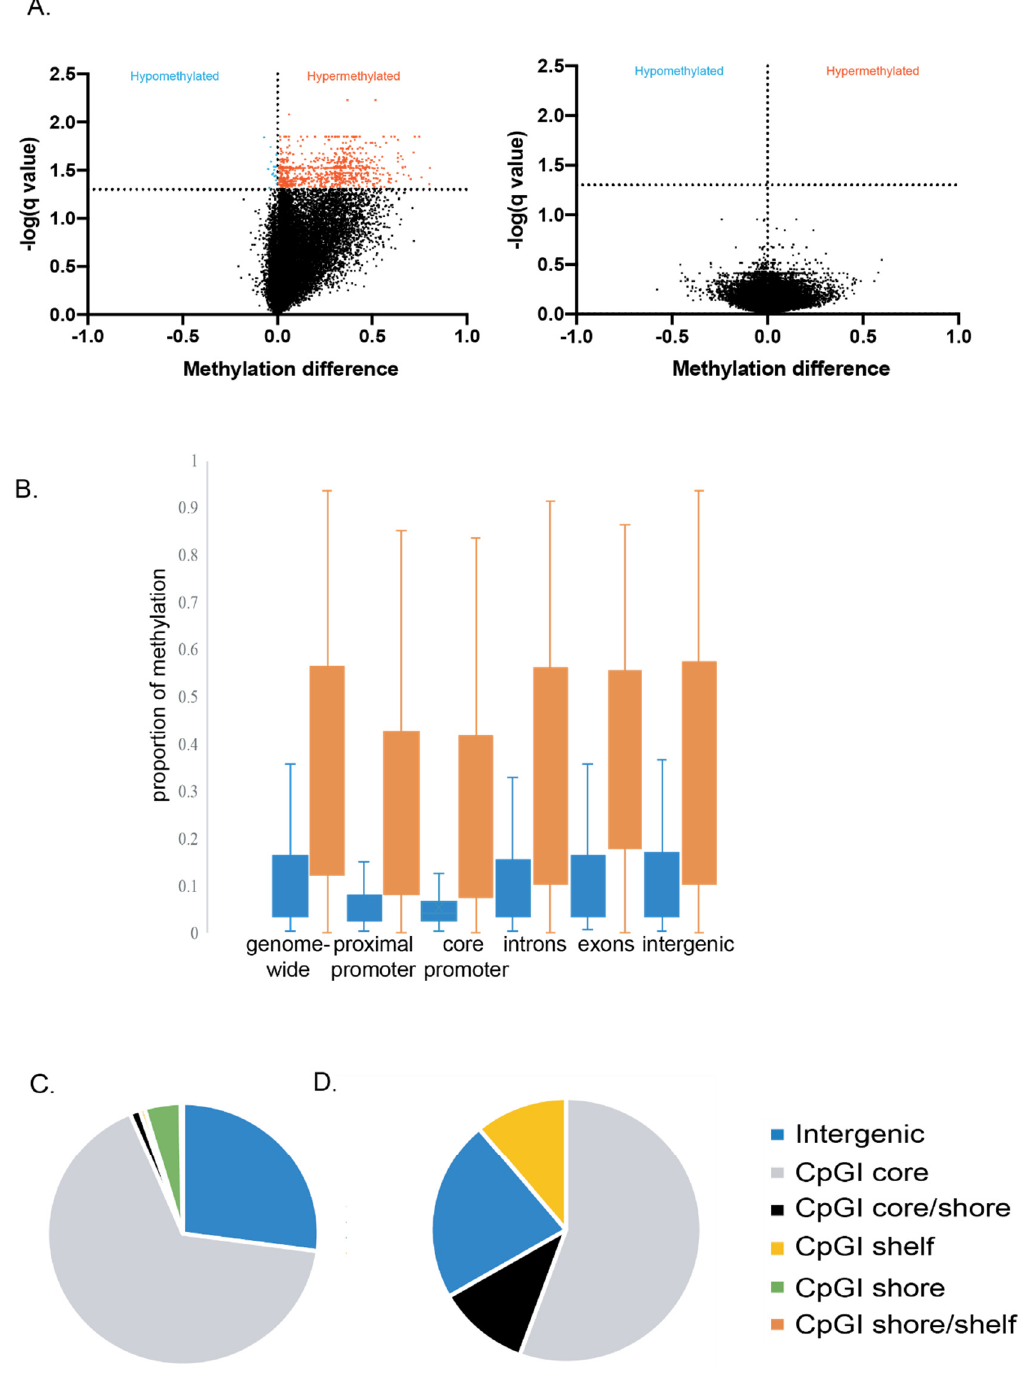
Figure 2. Global methylation description. ( A ) Volcano plots of differentially methylated fragments (DMFs) in comparison of MmuPV1 infected then regressed to mock infected then regressed control tissue (left) and actively infected to mock infected control tissue (right). Horizontal dotted line represents Benjamini-Hochberg false-discovery rate of 5% to control for multiple t-tests. Vertical dotted line represents a mean difference of 0 in the proportion of methylation between groups; ( B ) Proportion of methylated DMFs by genomic region for regressed control tissues (blue) and regressed (orange). Data are represented in quartiles with whiskers indicating outliers outside of upper and lower quartiles. ( C ) Within CpG islands, differentially hypermethylated regions ( n = 328) and ( D ) hypomethylated regions ( n = 9) were located predominantly in the core.